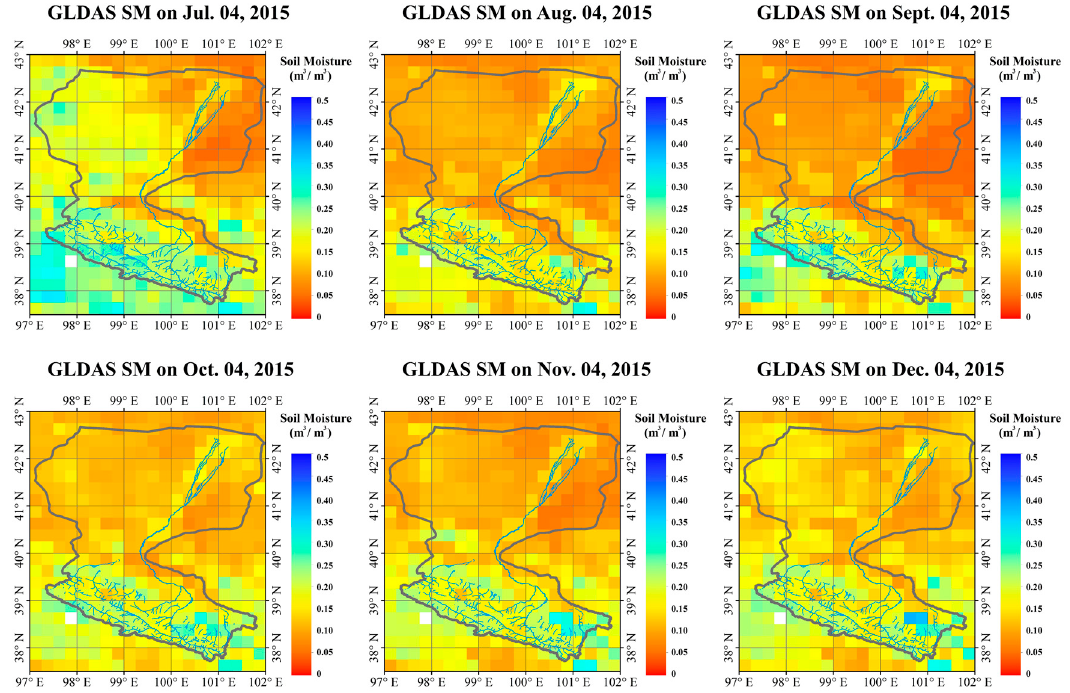
Figure 9. Maps of the spatial distribution of GLDAS SM covering the HRB on the 4th day of each month in 2015.